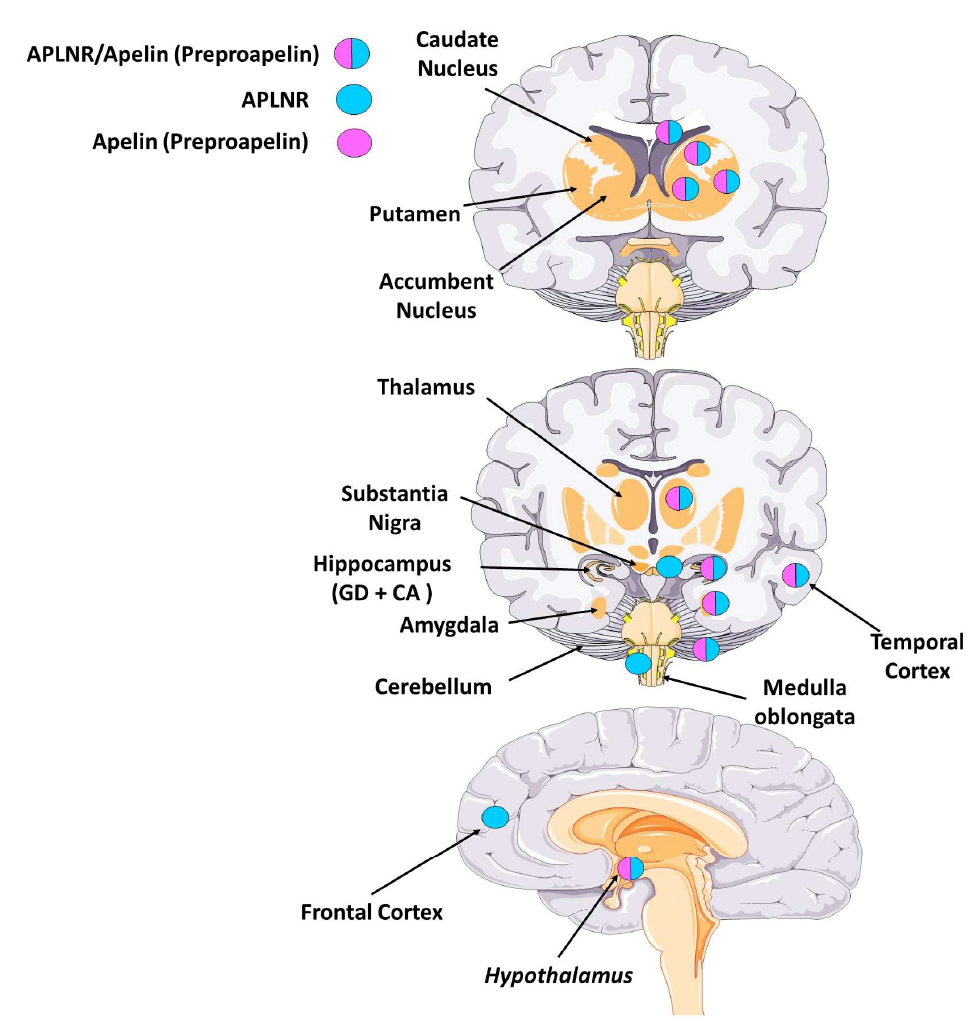
Figure 3. Expression of APLNR and Apelin ligand in the normal human brain. Schematic representation depicting the adult human brain at different levels showing the structures in which APLNR and Apelin ligand are expressed. Table 1. Table with different brain regions in the human brain with known expression of APLNR and Apelin ligand.